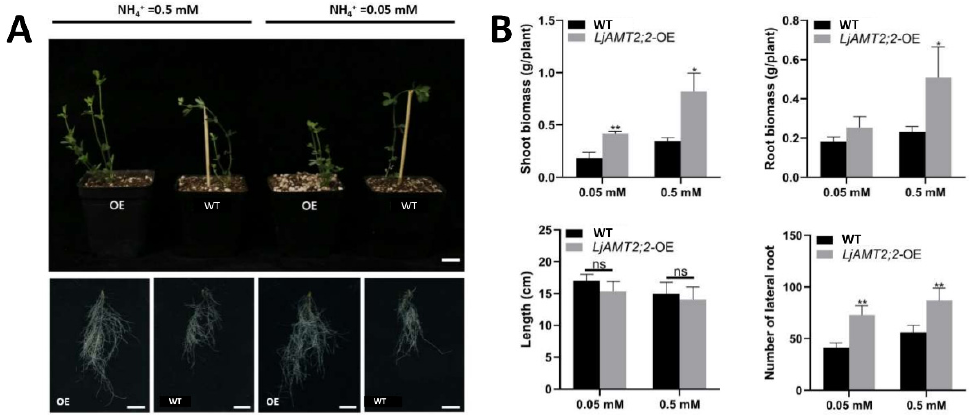
Figure 6. Comparison of phenotypes between LjAMT2;2-OE and wild-type plants. ( A ) Growth status of aboveground and underground parts of plants. ( B ) Biomass statistics and LjAMT2;2 gene expression levels. Data are means ± standard error (SE; n ≥ 3 biological replicates; * p ≤ 0.05, ** p ≤ 0.01,ns: no significant difference).